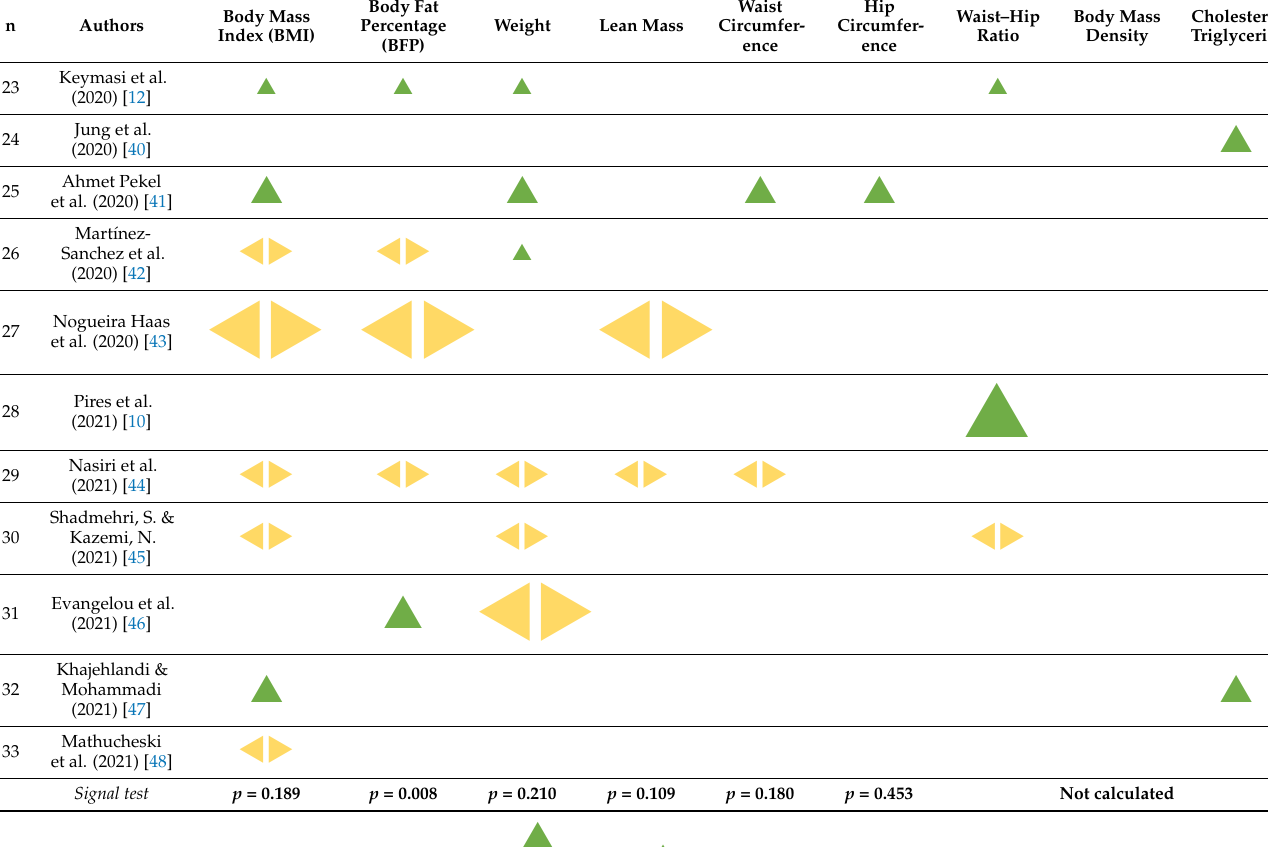
Table 2. Cont. Table 2. Effect direction plot and signal test.